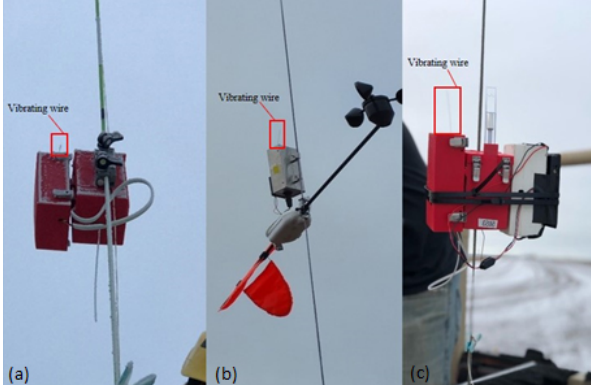
Figure 2. Anasphere SLWC sonde left of InterMet radiosonde on TBS tether (a) . Anasphere SLWC sonde above Anasphere tether- sonde (b) . InterMet radiosonde in center with Anasphere SLWC sonde on left and Reading SLWC sonde on right (c)